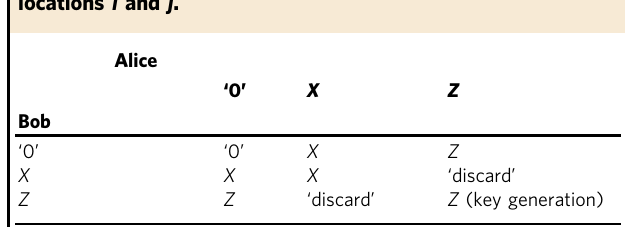
Table 3 Alice and Bob ’ s basis sifting procedure on the paired locations i and j